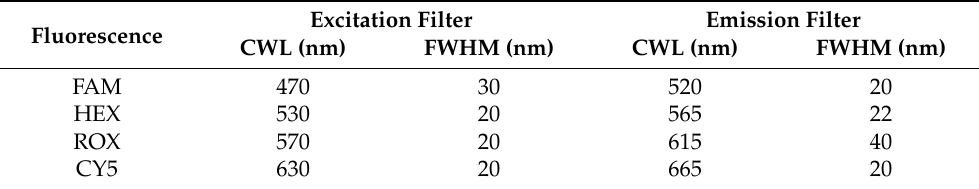
Table 1. Center wavelength (CWL) and full width at half-maximum (FWHM) of excitation and emission filters used in the proposed system. Table 2. The part number, manufacturer, and millicandela rating of the LED mounted on the excitation device.